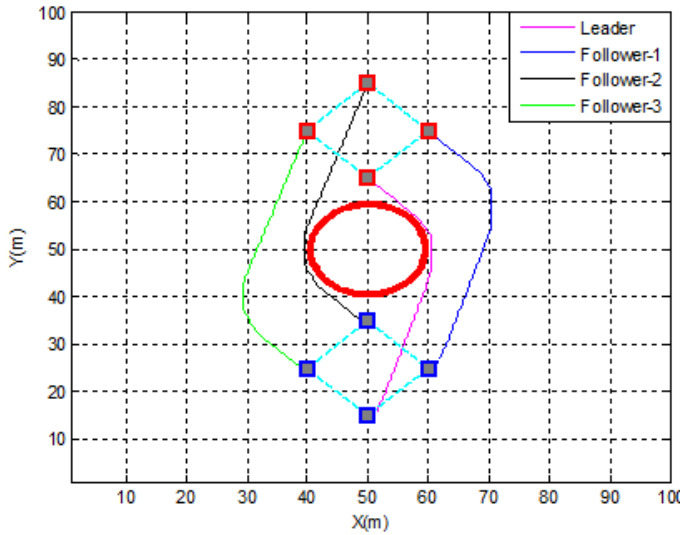
Figure 13. Obstacles avoidance.